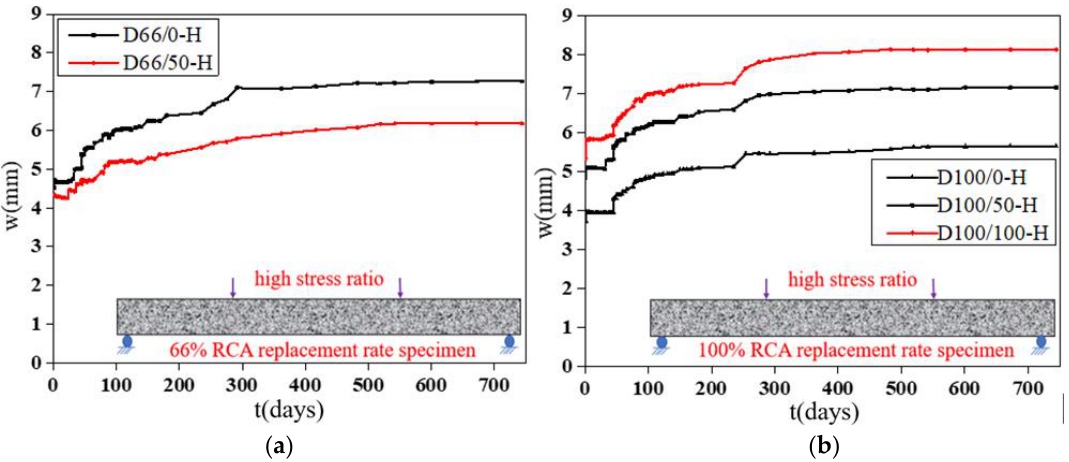
Figure 11. Deflection-load holding time curves of the specimens with different RFA replacement ratios. ( a ) Specimens with a 66% RCA replacement rate; ( b ) specimens with a 100% RCA replacement rate.